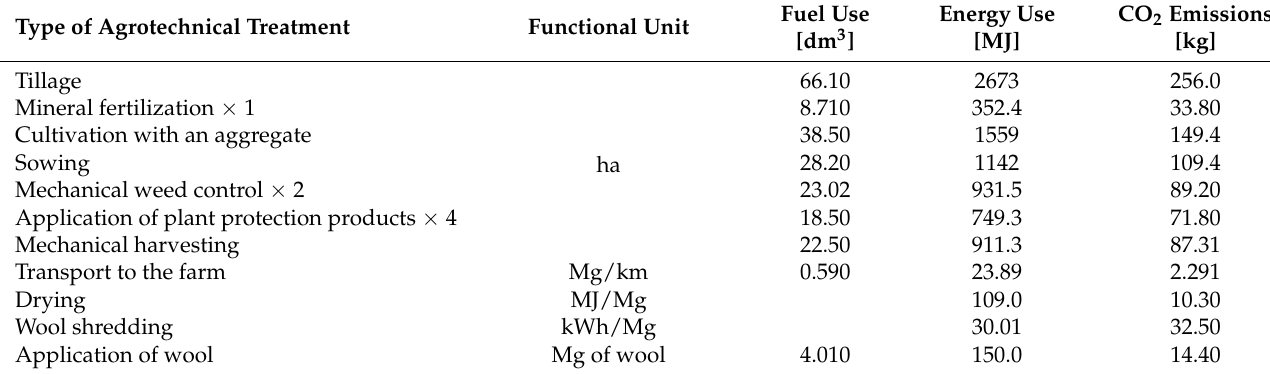
Table 4. Energy consumption and GHG emissions related to agrotechnical treatments.